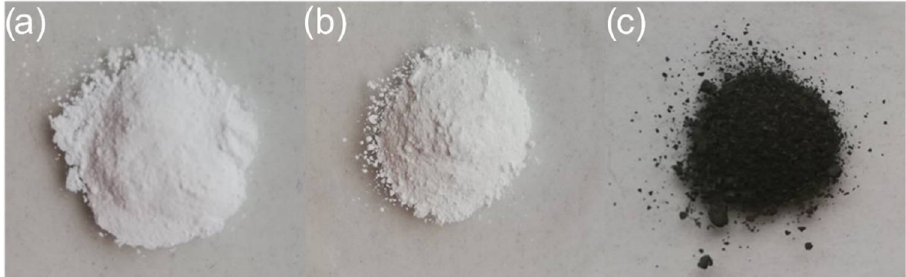
Figure 1. Photos of obtained materials: ( a ) TiO 2 NPs, ( b ) TiO 2 /SiO 2 , and ( c ) TiO 2 /Ag.